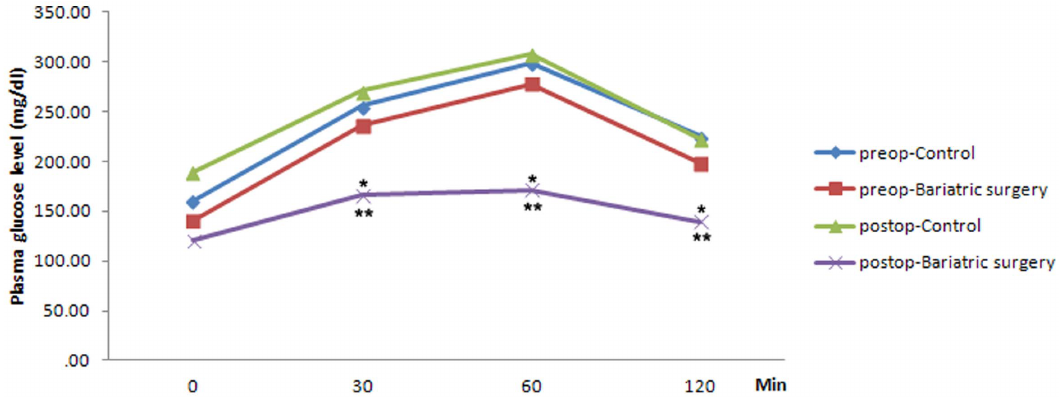
Figure 2. Oral glucose tolerance test before and after bariatric surgery in rats (*: compared with preoperative bariatric surgery, p=0.037 **: compared with postoperative control group, p=0.014).